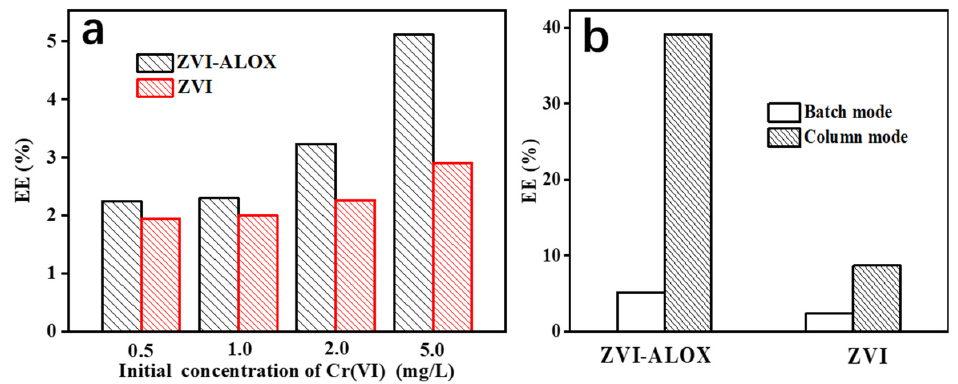
Figure 7. Effects of key parameters on the EE of ZVI-ALOX and ZVI: ( a ) effect of initial Cr(VI) concen- tration in batch mode; ( b ) effect of batch and column modes (inflow concentration 5 mg/L Cr(VI)).